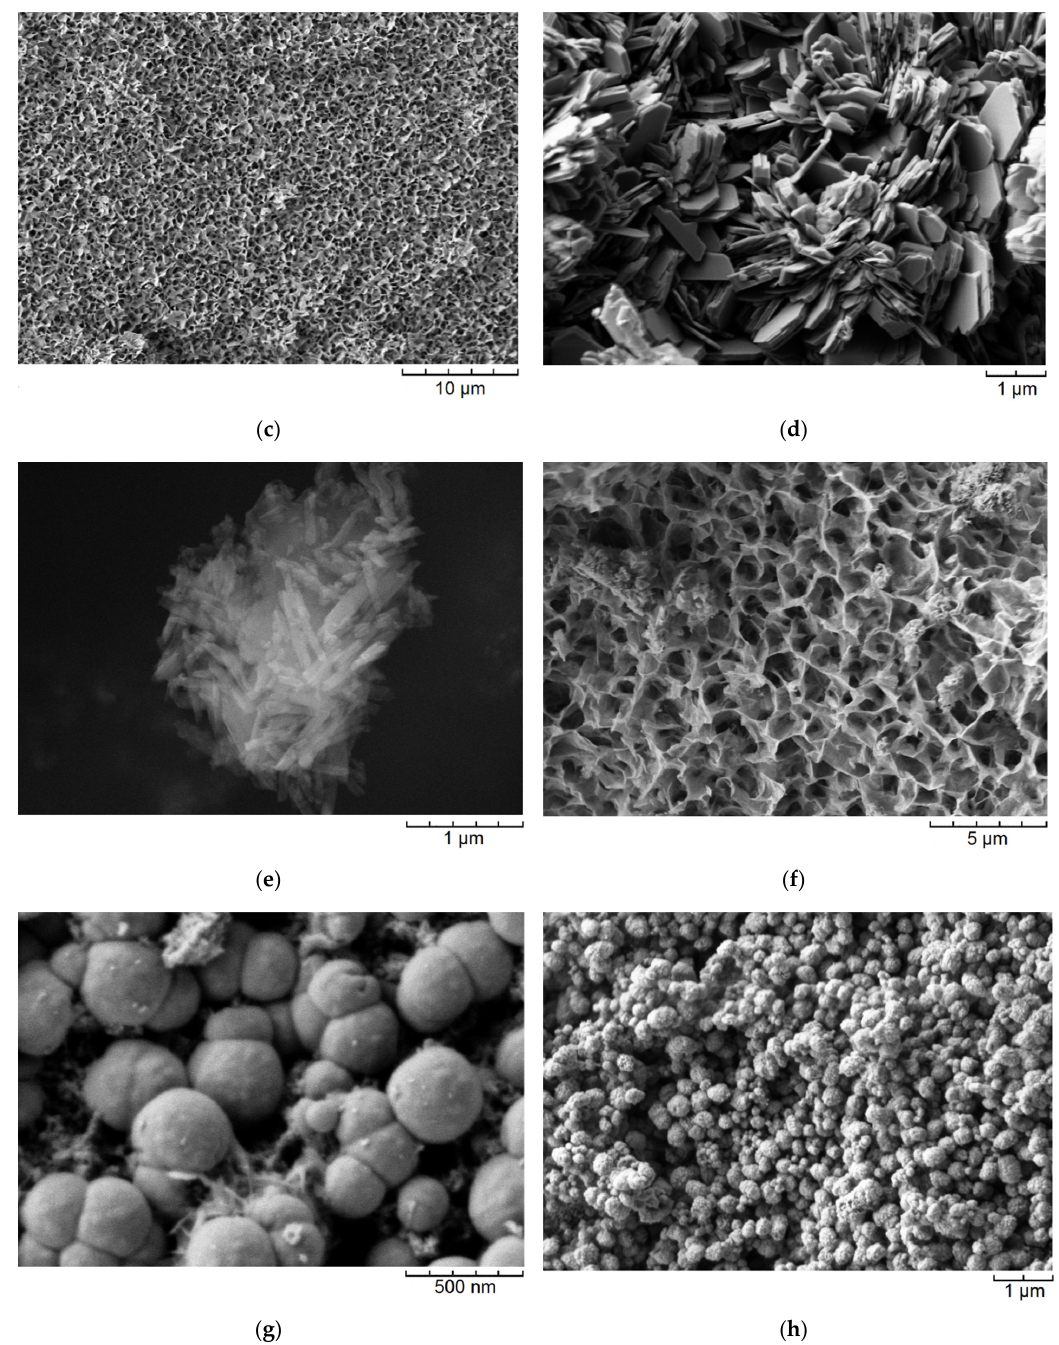
Figure 2. SEM images of the samples: ( a )—MT-Al0; ( b )—MT-Al0.2; ( c )—MT-Al1.0; ( d )—Kaol-pl; ( e )—Hal; ( f )—Kaol-sponge; ( g )—Kaol-sph; and ( h )—Beta. Samples are designated in accordance with the designations presented in Table 1.